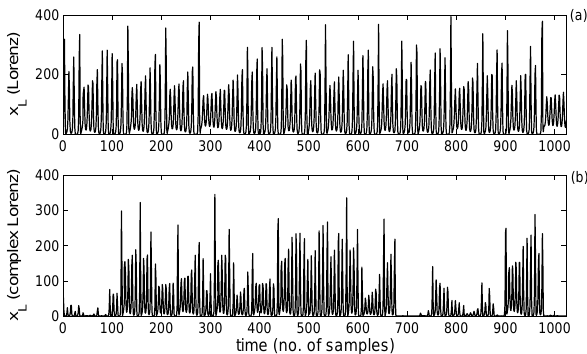
Fig. 7. Output from the two models for the laser series, formed by squaring the y 1 output from Eqs. (6) and (7), which may be compared to the series, x L , in Fig. 4a and a surrogate with ρ = 0 . 97 in Fig.